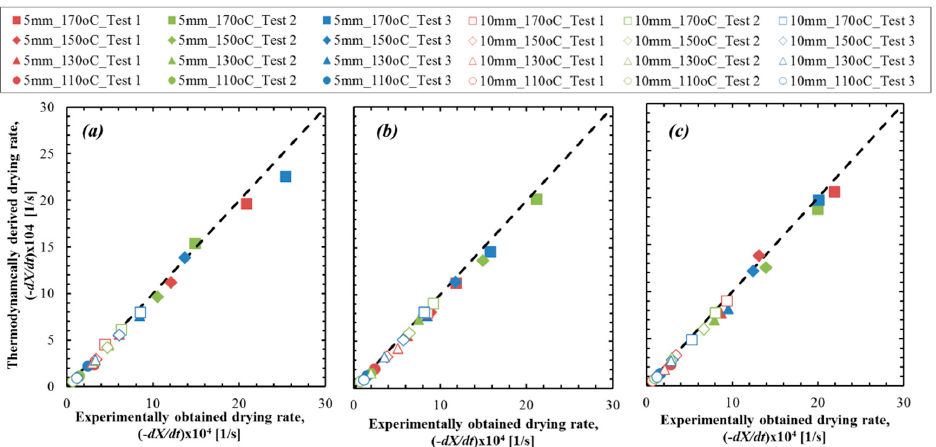
Figure 11. Comparison between the experimentally obtained drying rate and thermodynamically derived drying rate at the constant drying rate period (CDRP). The results for: ( a ) T1; ( b ) T2; and ( c ) T3 samples.